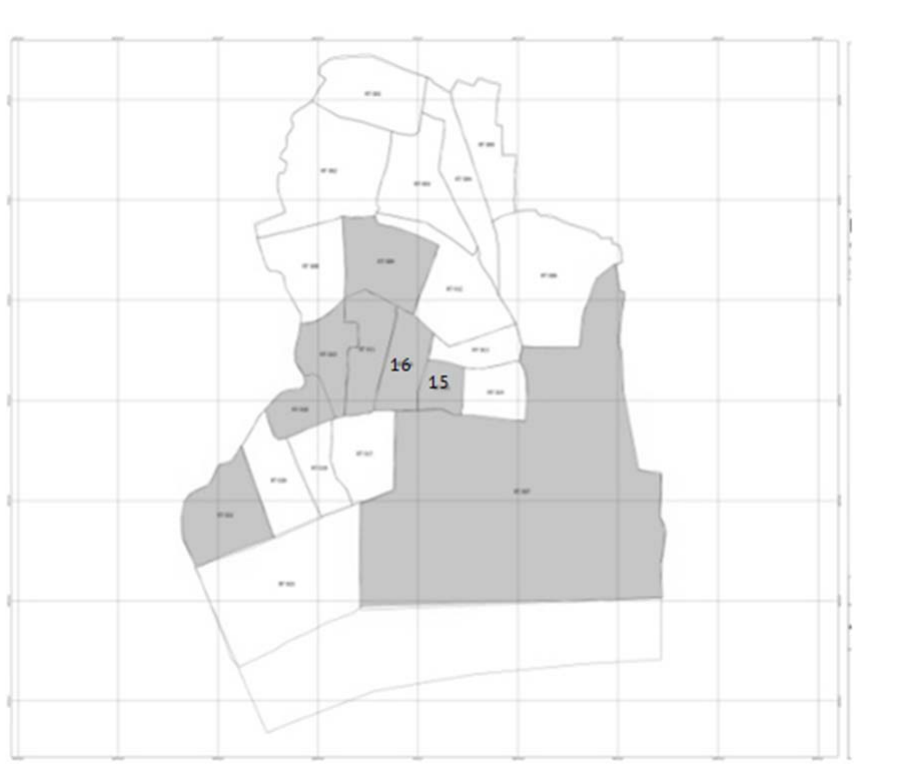
Figure 1. Map of Lawang Kidul